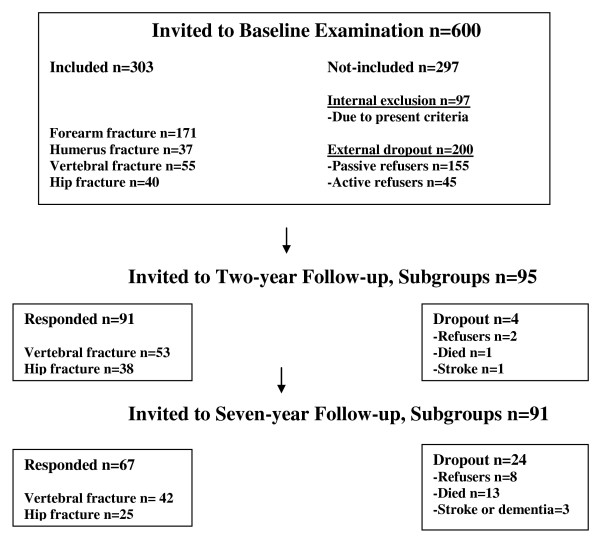
Flowchart of participant recruitment, inclusion and dropout.